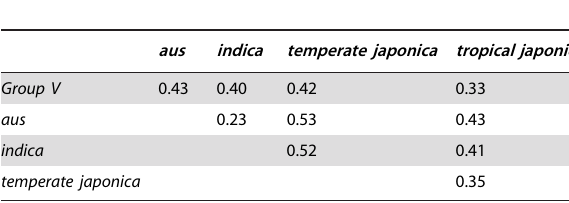
Table 1. Fst between pairwise subpopulation